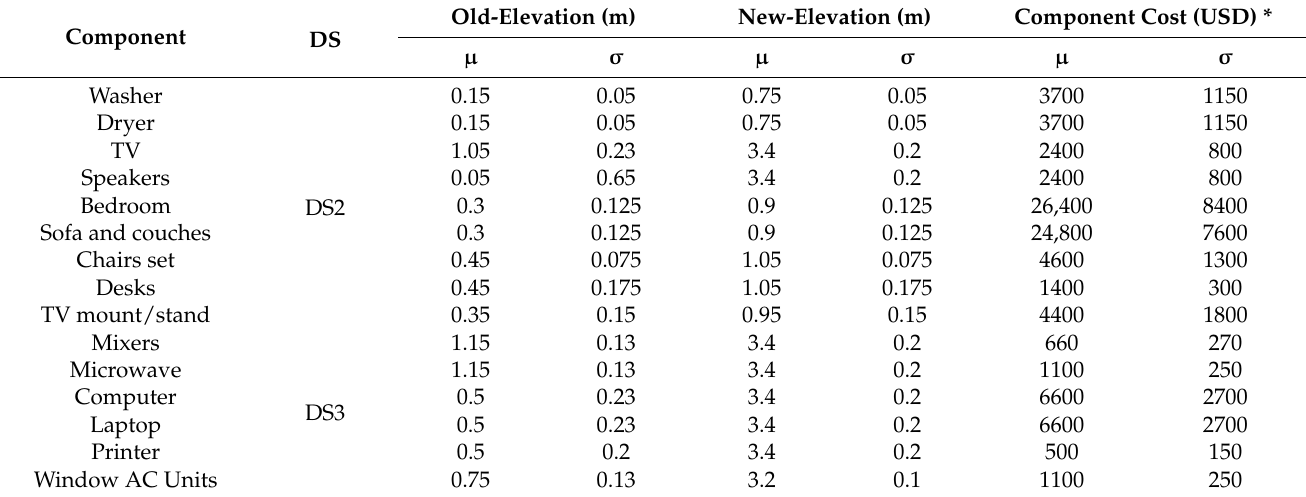
Figure 4. A schematic representation for a building with elevated content and front-door flood barrier. Table 4. The mean and standard deviation of the old and new damaging elevation of the water-sensitive components along with their replacement